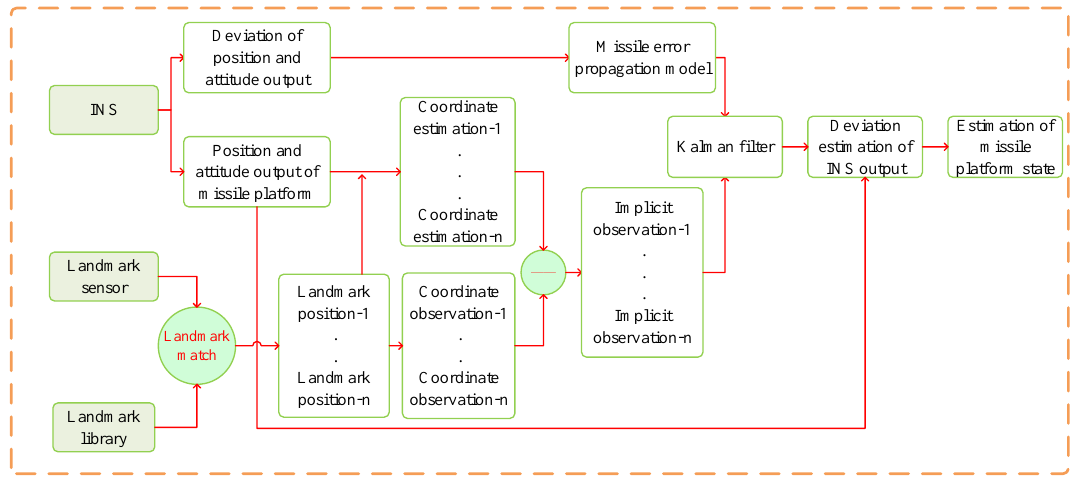
Figure 1. Autonomous navigation scheme of Landmark-based Inertial Navigation System